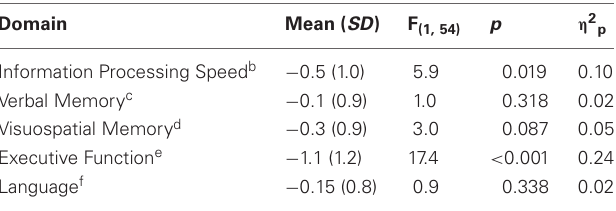
Table 5 | Percentage of Participants Exhibiting Cognitive deficits (defined as 10th percentil below comparison group) and mean number of deficits for patients with LLD and